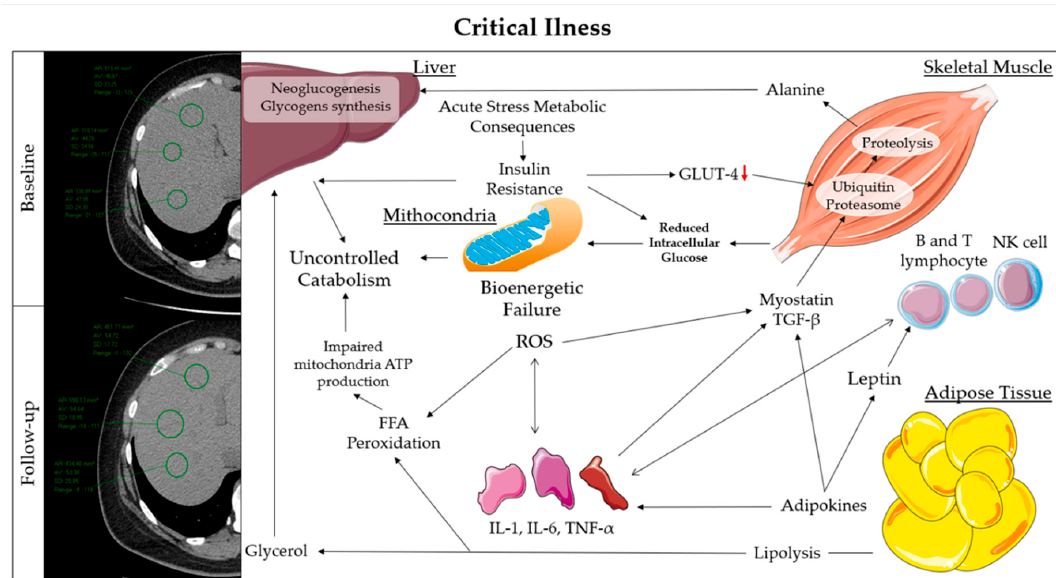
Figure 2. ( Right ) representation of metabolic pathways in response to critical condition. ( Left ) difference to CT images of liver attenuation between baseline and follow-up. FFA: Free Fatty Acids; GLUT: Glucose Transporter; IL: Interleukin; NK: Natural Killer; ROS: Reactive Oxygen Species; TGF: Transforming Growth Factor; TNF: Tumor necrosis factor.